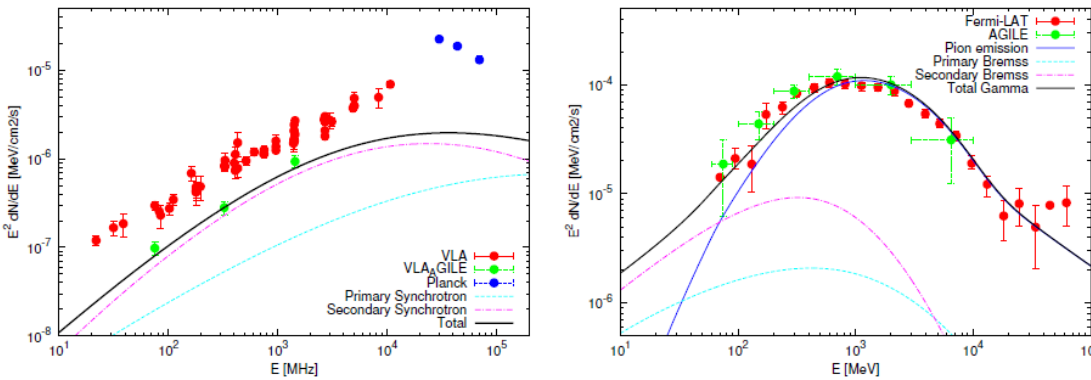
Figure 2. Radio and γ -ray data from W44 fitted with the best re-acceleration model. Left: VLA (red) and Planck (blue) radio data from the whole remnant and VLA radio data from the AGILE emitting region (green). Primary, secondary, and total synchrotron radio emission from the model are indicated from cyan dashed line, magenta dot-dashed and black line, respectively. Right: AGILE (green) and Fermi-LAT (red) γ -ray points plotted with γ -ray emission from pion decay (blue dotted line), from bremsstrahlung of primary (cyan dashed line), and secondary (magenta dot-dashed line) electrons, and total emission (black line). Figure from [37].